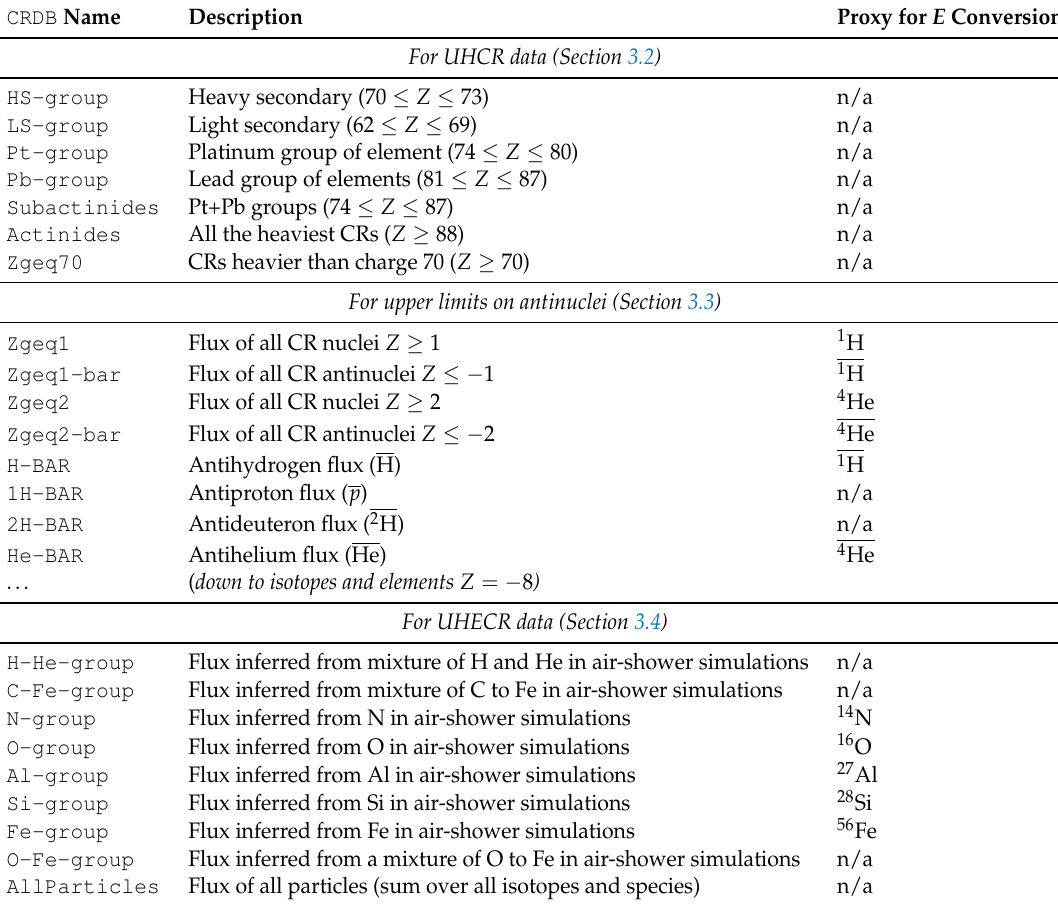
Table A2. List of new CRDB names for CR_QUANTITY (see Section 2.1), along with their proxy (i.e., isotope) used to perform approximate energy axis conversions (n/a indicates that no energy conversion at all is